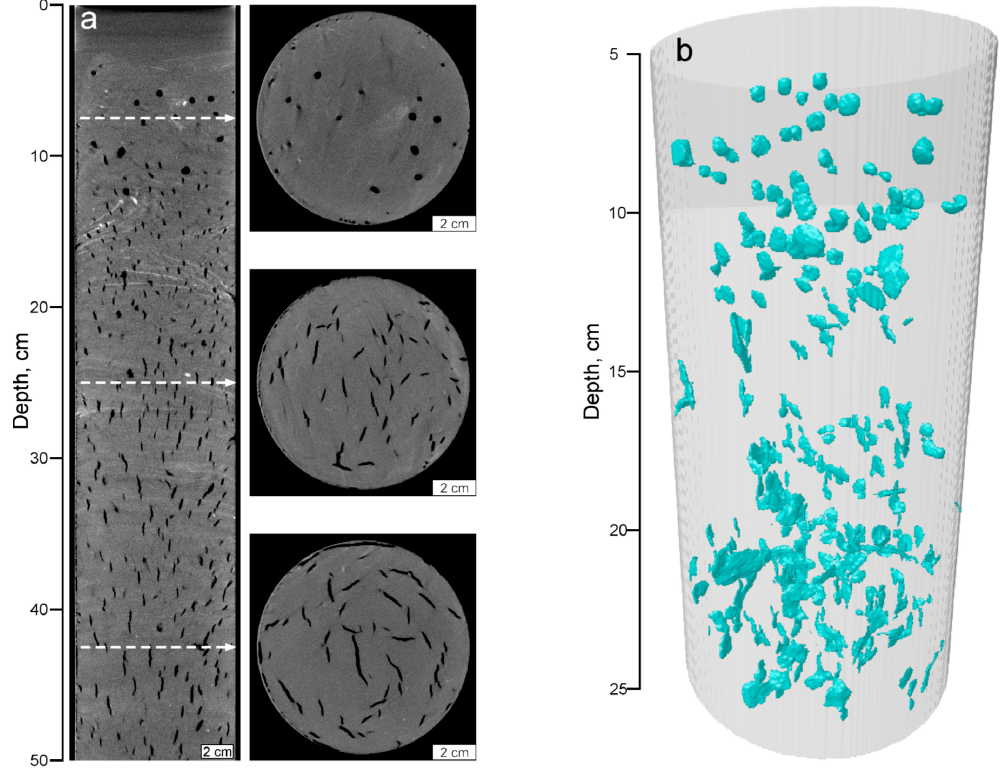
Figure 15. ( a ) Vertical and separate horizontal radiographic contrast section views of the upper 50 cm in core ONG-1; ( b ) three-dimensional model of the cavity distribution (within the upper 25 cm) resulting from degassing of the sediments.